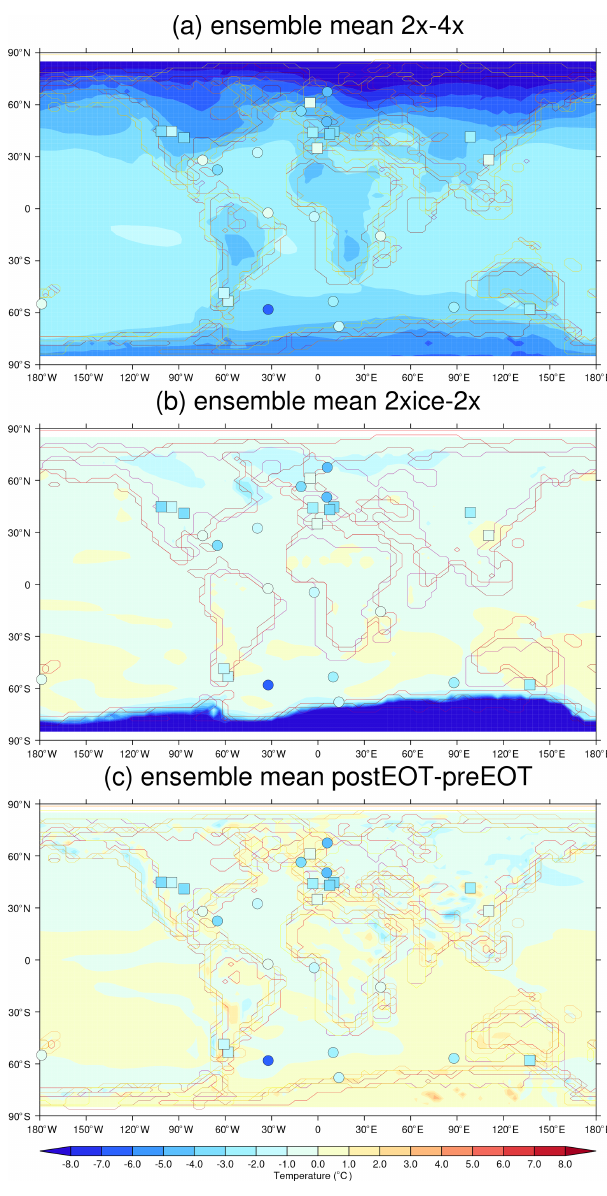
Figure 7. Ensemble mean modelled SAT response to (a) CO 2 halv- ing ( (cid:49)T CO 2 ), (b) onset of ice on Antarctica ( (cid:49)T ICE) and (c) palaeogeographic change ( (cid:49)T GEO) across the EOT. The continen- tal outlines for all models in each ensemble are shown. The marine proxy data are shown as filled circles, while the terrestrial proxy data are shown as filled